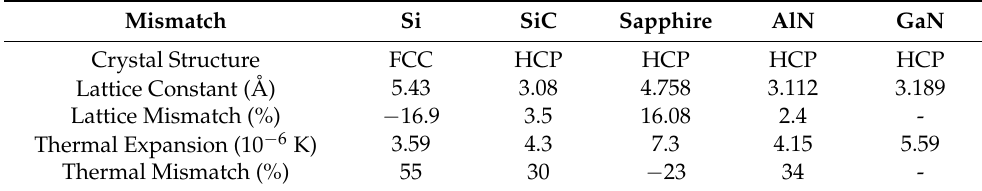
Table 1. The lattice and thermal mismatch of Si, SiC, Sapphire, AlN, and GaN [46]. Mismatch Si SiC Sapphire AlN GaN Crystal Structure FCC HCP HCP Lattice Constant